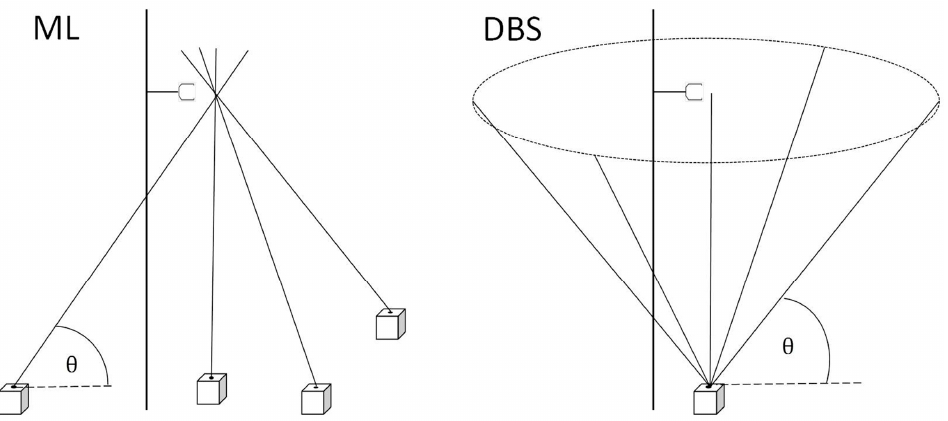
Figure 1. Sketch of the multi-lidar (ML) and Doppler beam swinging (DBS) strategies next to a reference mast with a sonic as used in this study. Note that the angles and positions of the lidars differ from the instrument setup for reasons of illustrative clarity.